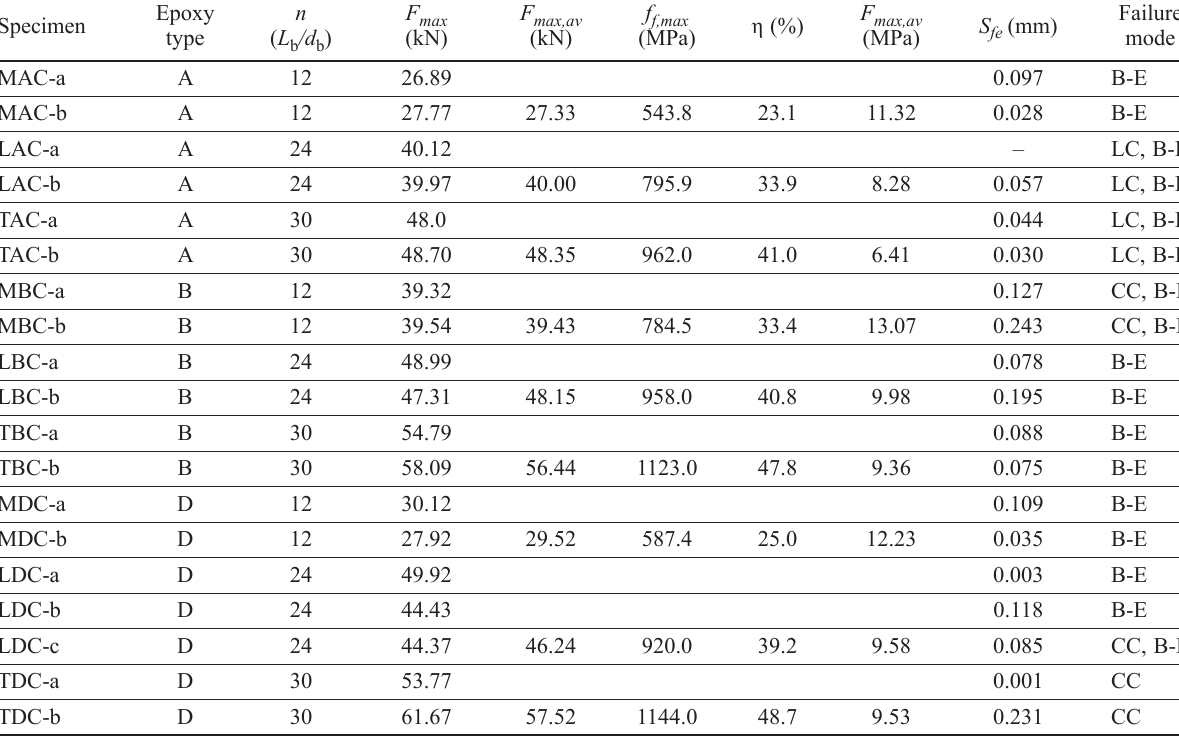
Table 2. Test results for specimens with CFRP bars Specimen